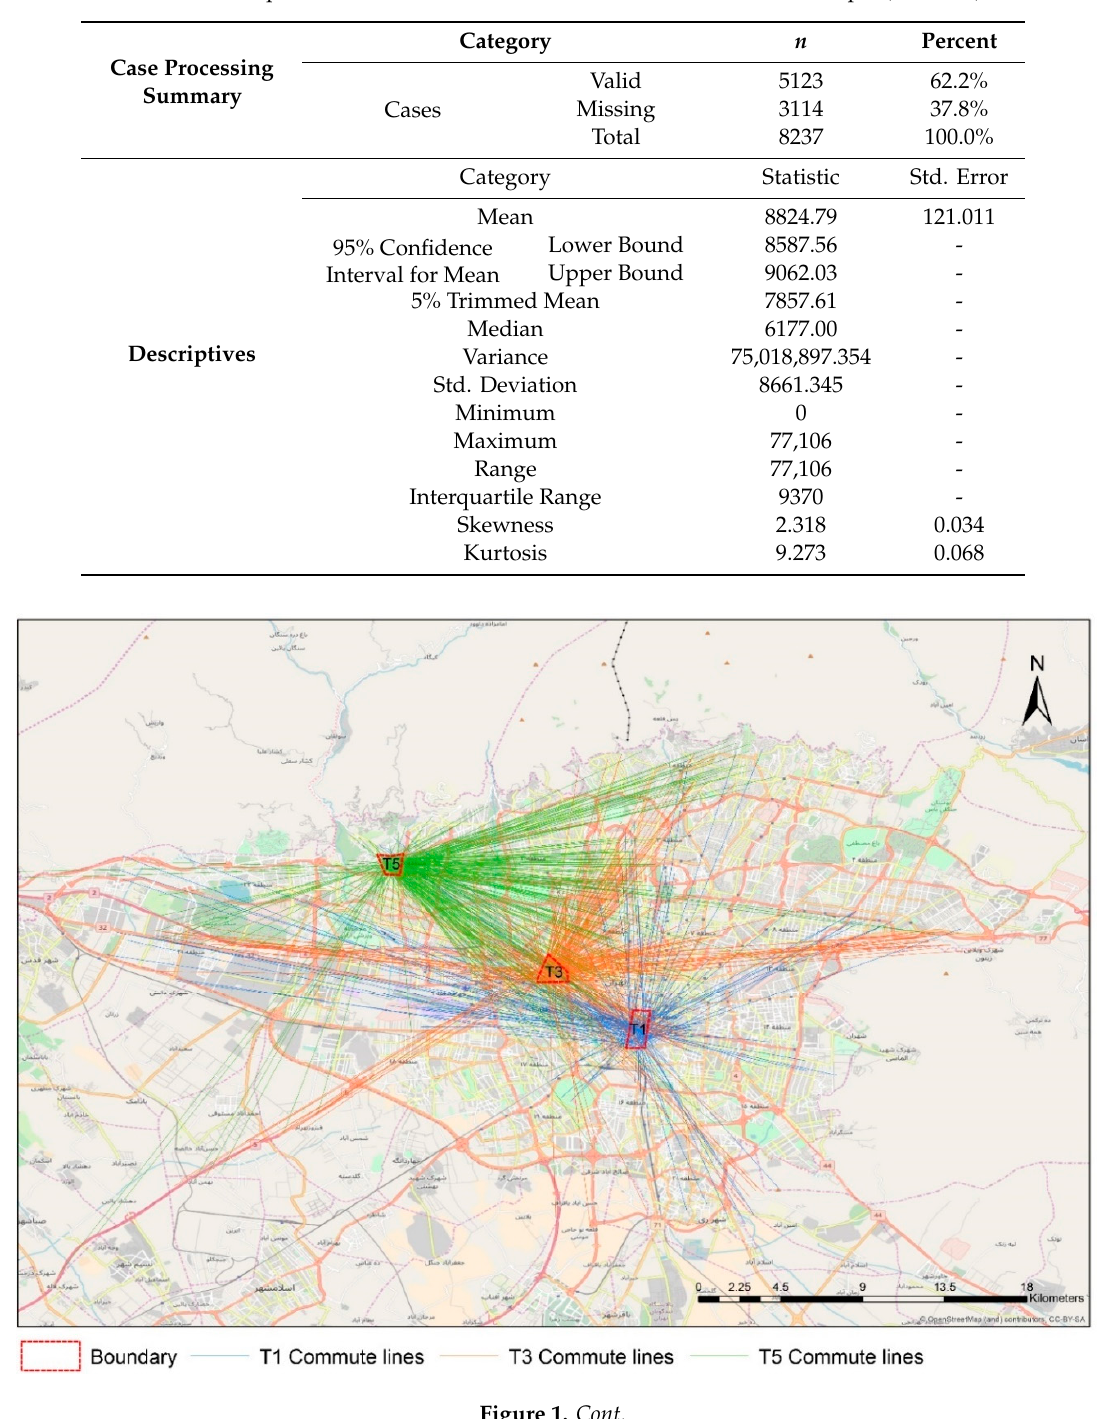
Table 1. Descriptive statistics of the commute distances of the overall sample ( n = 8237).